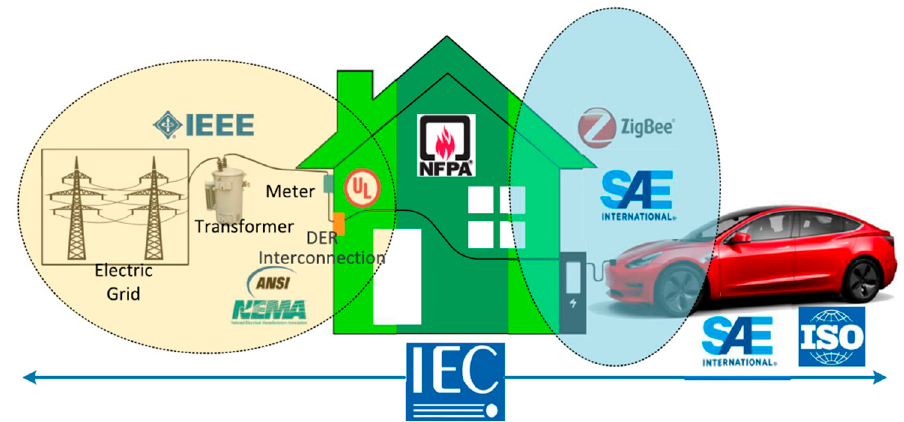
Figure 17. Charging related standards in residential charging [115].